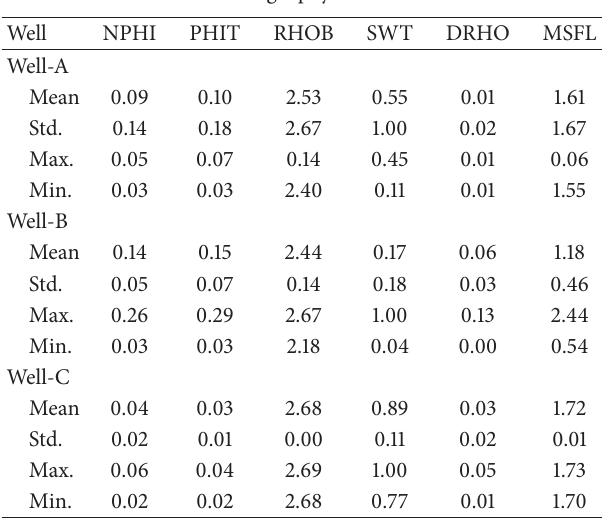
Table 2: Statistics of the geophysical data for all the